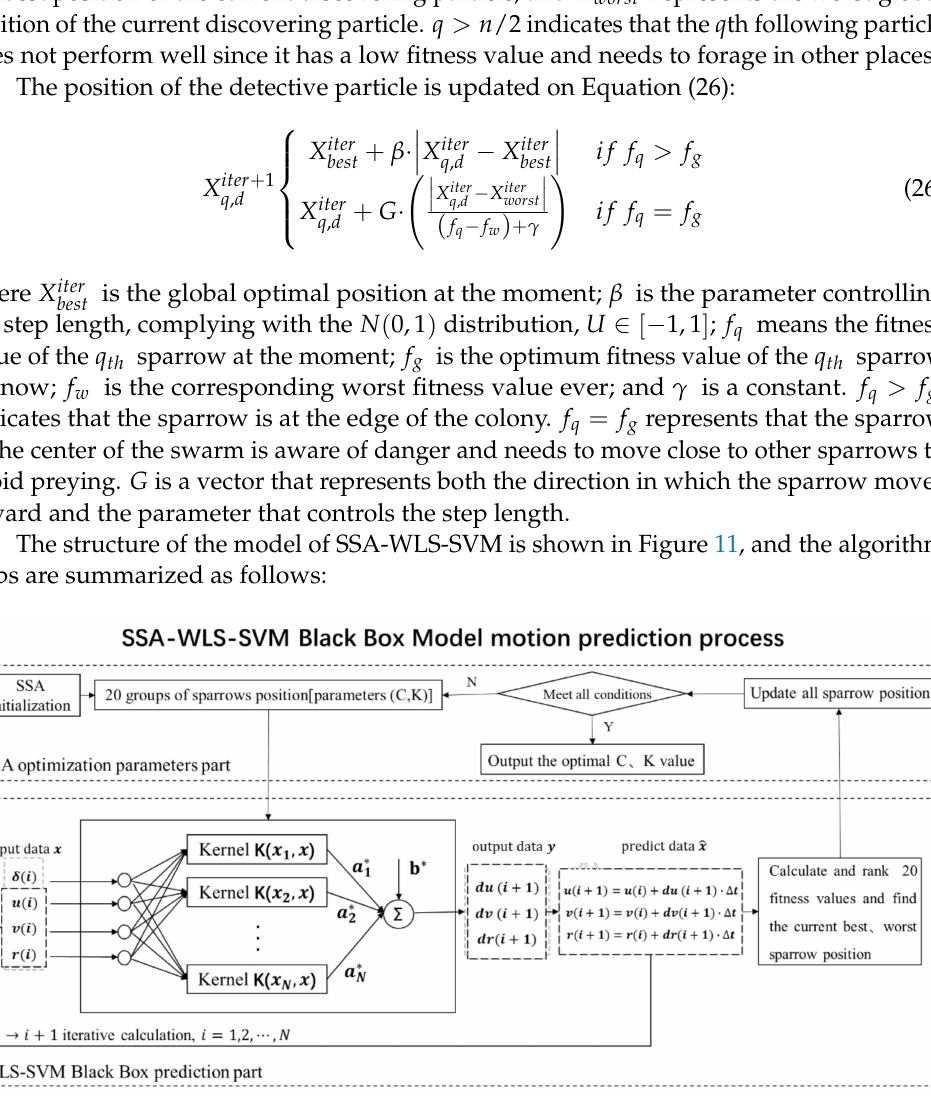
Figure 11. SSA-WLS-SVM Black-Box Model motion prediction process. (1) The sample set S = { ( x i , y i ) , ( x i , y i ) ∈ R N , i = 1, 2, · · · , N } given by WLS-SVM is taken as the benchmark, the regularization parameter C and kernel parameter K of WLS-SVM were taken as the optimization objects of the SSA algorithm. The